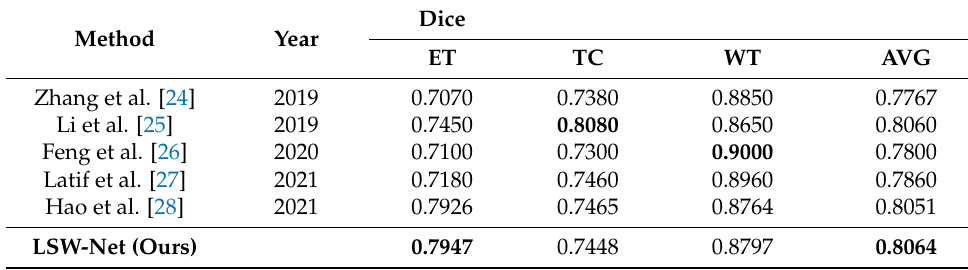
Table 3. Comparison of LSW-Net model with some advanced algorithms on BraTS2020.